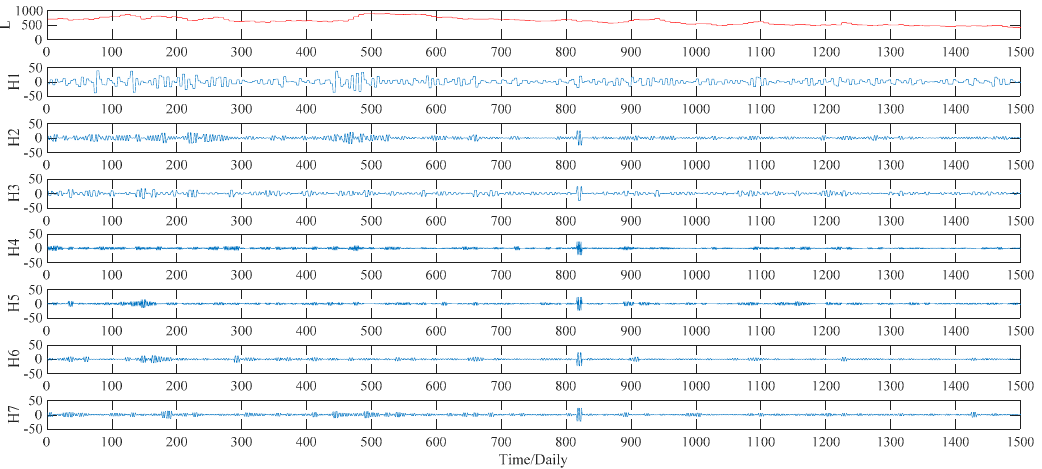
Figure 9. Decomposition results of the intrinsic time-scale decomposition (ITD) method (wheat). Figure 10. Decomposition results of the variational mode decomposition (VMD) method (wheat).